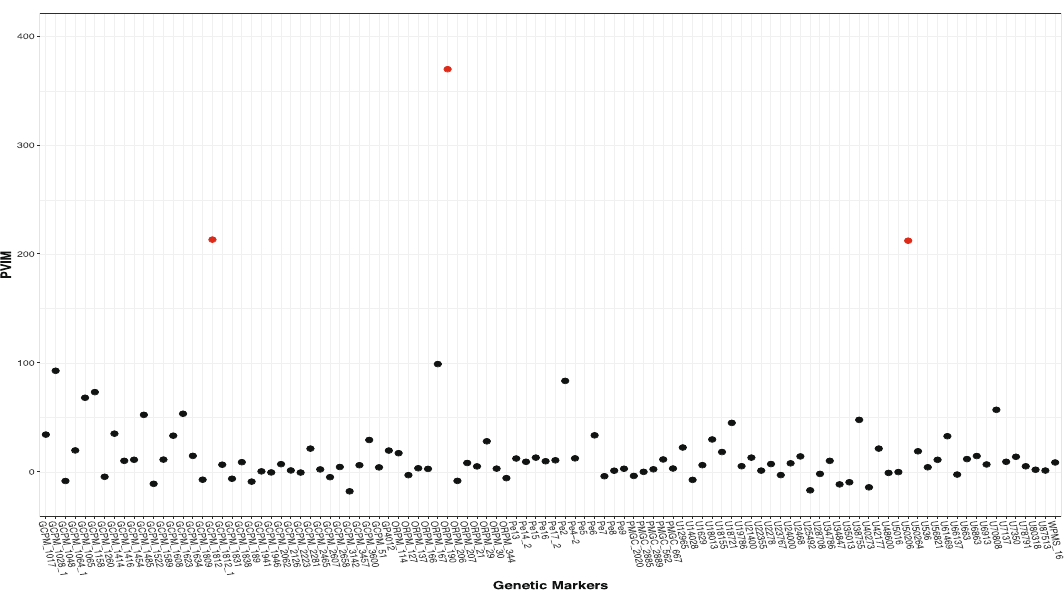
Figure 5. Prediction variable importance measures of 104 genetic markers. The highest PVIMs are highlighted with red